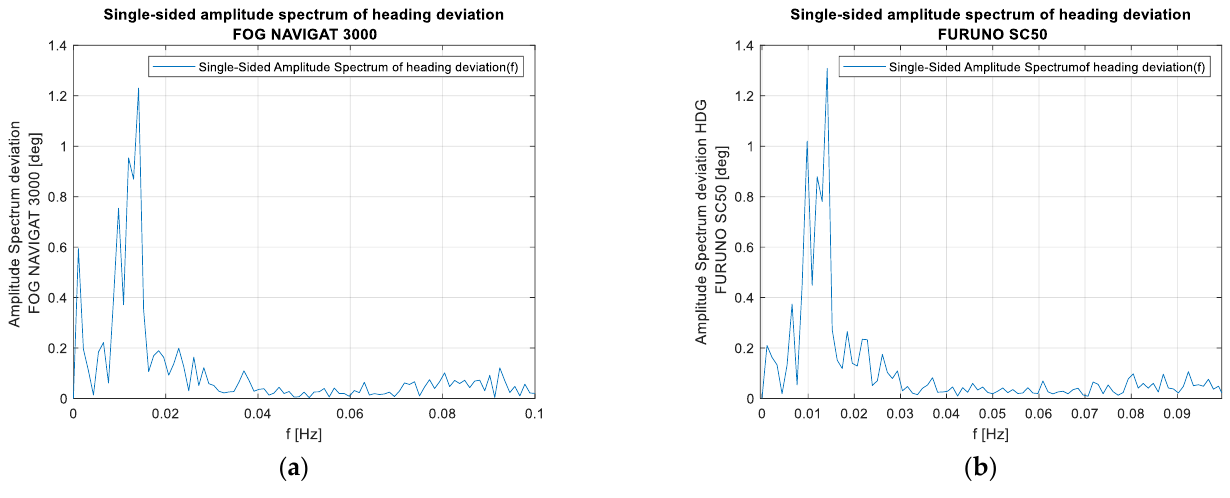
Figure 6. The spectrum of oscillations from recording #1 for the compasses ( a ) FOG NAVIGAT 3000 and ( b ) FURUNO SC50.